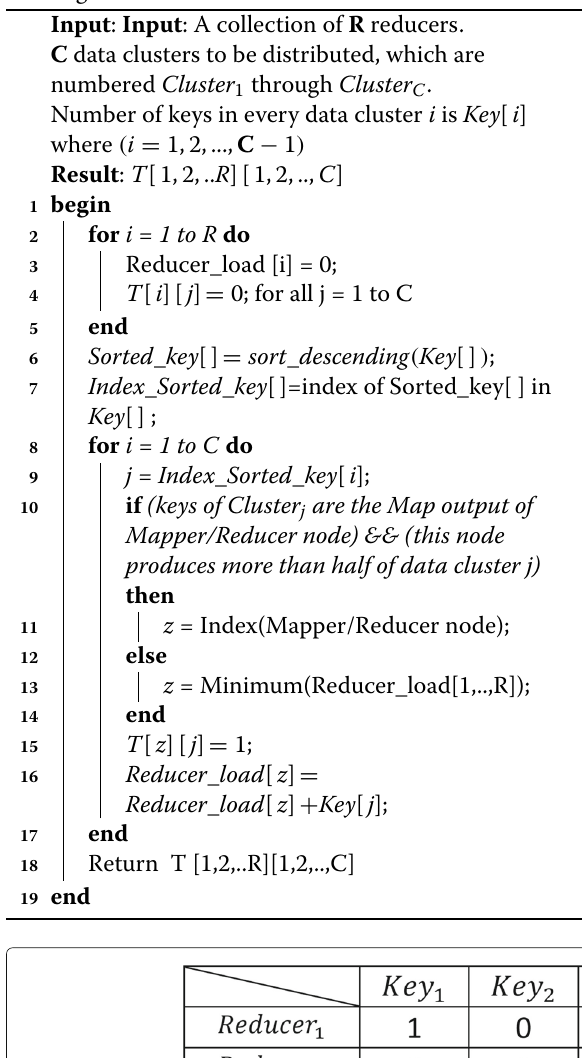
Algorithm 2: Data clusters assignment algorithm-